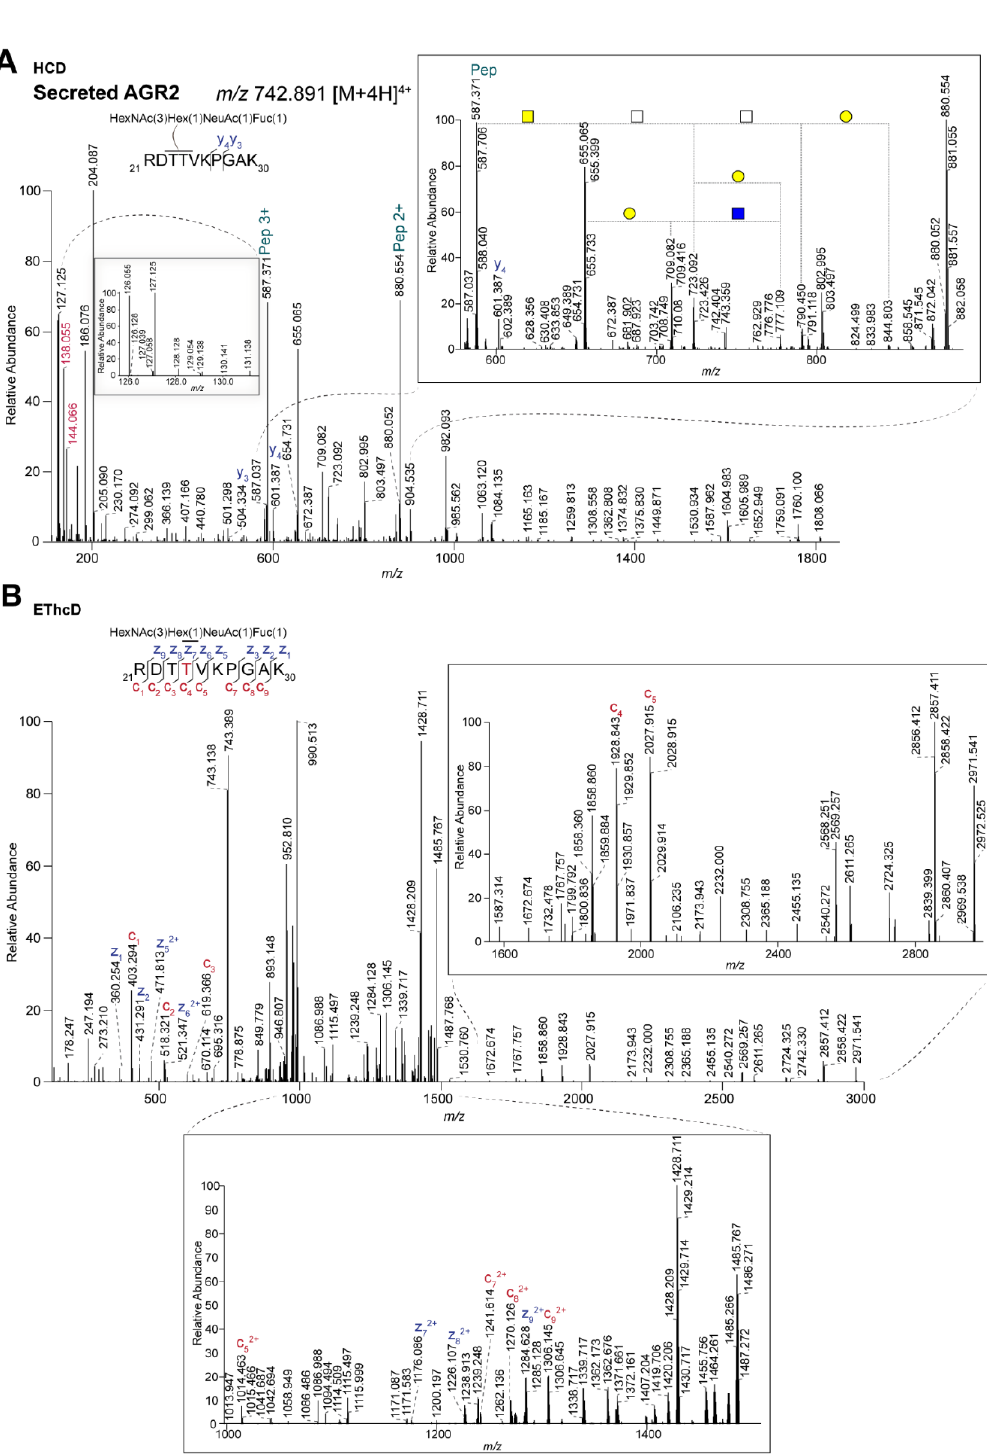
Figure 5. Identification of larger O- glycan structures on secreted AGR2. ( A ) HCD and ( B ) EThcD spectra of the TMT-labeled tryptic peptide RDTTVKPGAK from secreted AGR2, observed at m / z 742.891 [M+4H] 4+ , carrying a glycan composed of HexNAc(1)Hex(3)NeuAc(1)Fuc(1). Pep: peptide; Blue square: GlcNAc; yellow square: GalNAc; yellow circle: galactose. The inserts represent a zoom in of the spectra from m / z 580–890 ( A ), representing glycan fragmentation) and m / z 1000–1500 ( B ). c and z ions are represented in red and blue, respectively. Thr-4 (in red within the peptide sequence) indicates the glycosylation site.